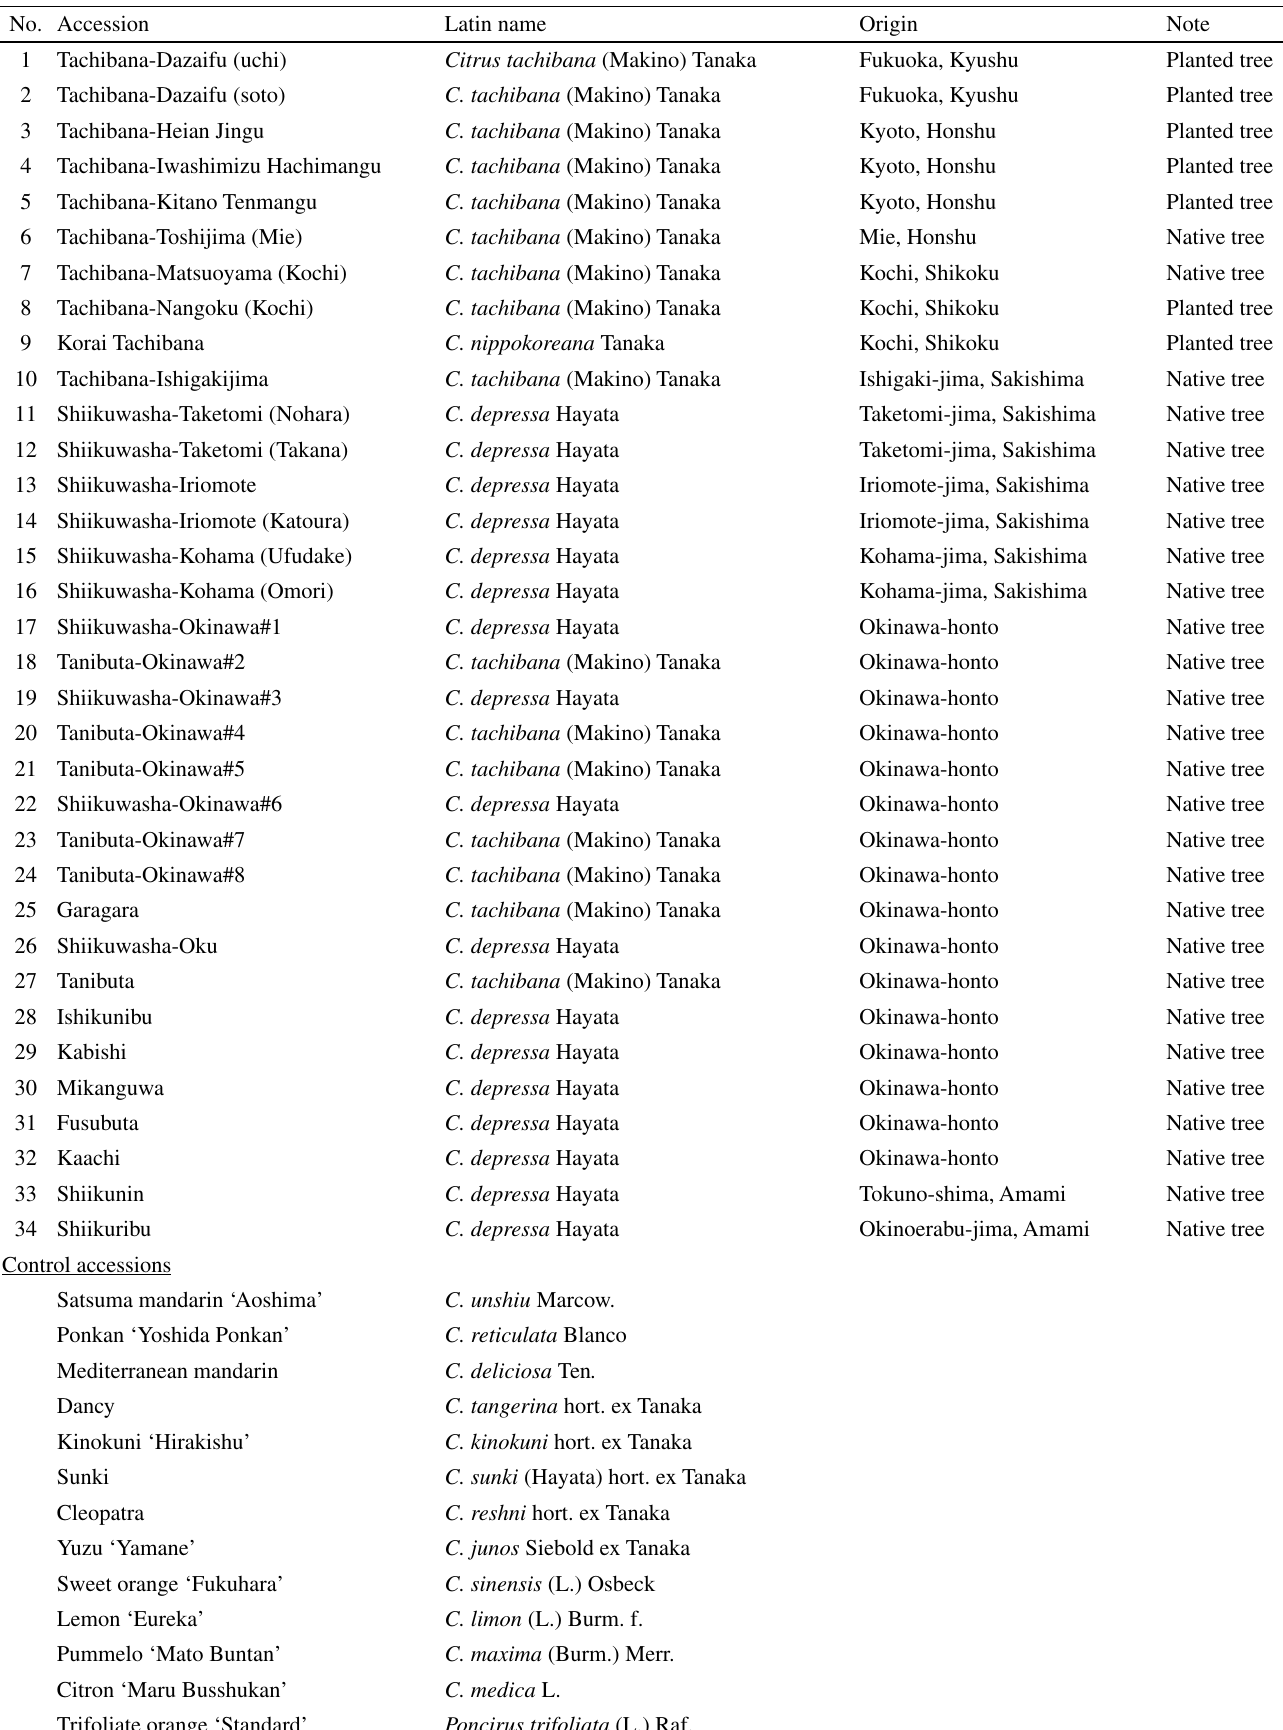
Table 1 - Citrus tachibana , C. nipponkoreana , and C. depressa accessions used in the present study No.